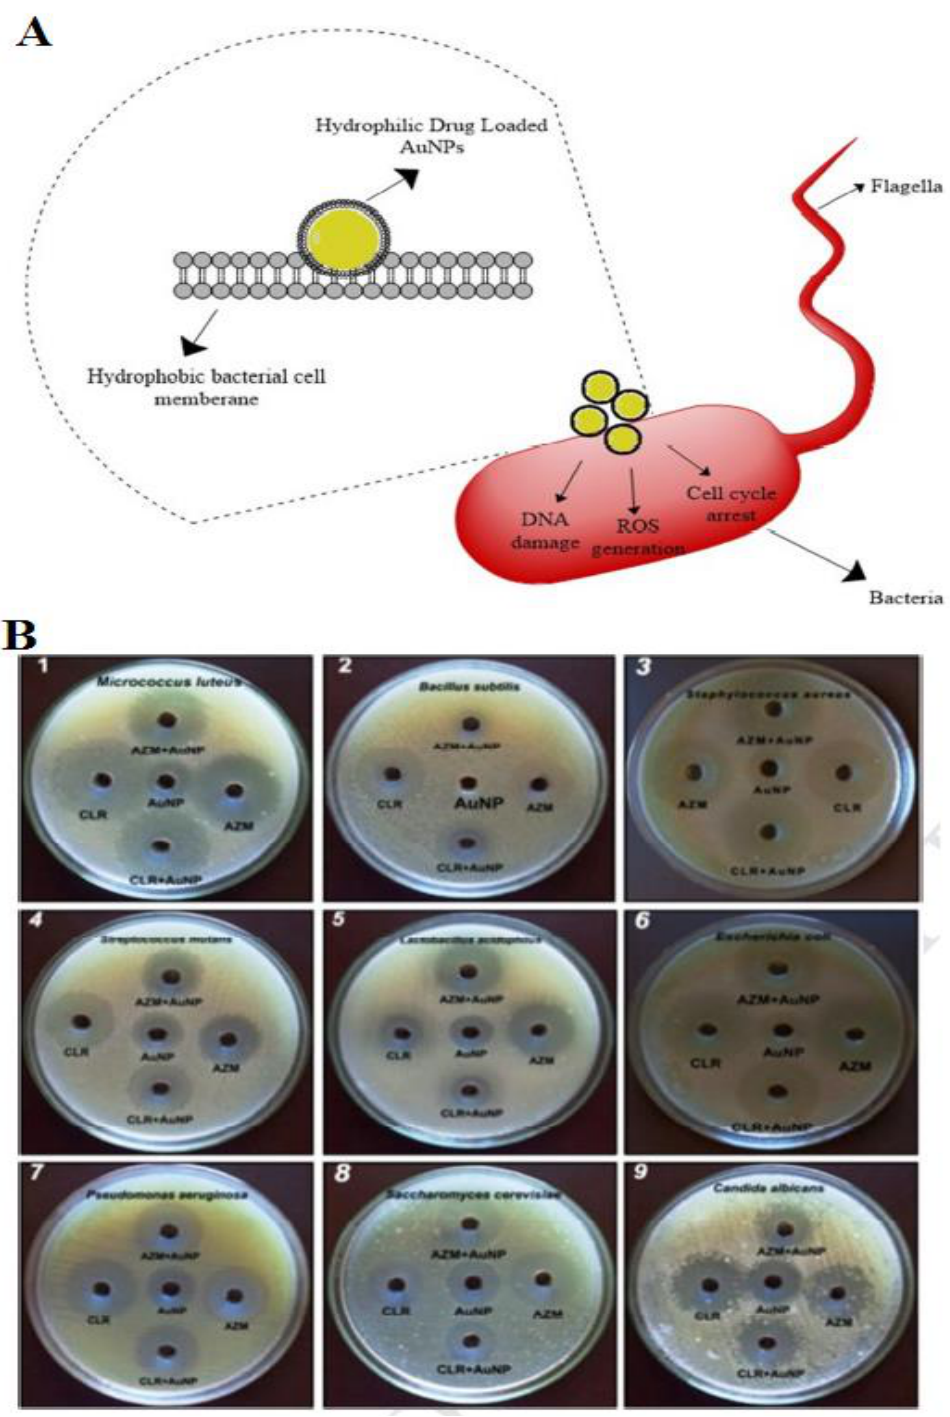
Figure 4. Schematic illustration of the killing of bacterial cells by Au NPs ( A ); schematic of spectrum antimicrobial activity of Au NPs, naked drug, and drug-loaded Au NPs against oral pathogenic pathogens. ( B ) The AuNPs (100 µ g) and drug-AuNPs show a wide-spectrum antimicrobial effect against the pathogens. AuNPs exhibited antimicrobial activity through the creation of a zone of inhibition ranging from about 17 mm against pathogens excluding B. subtilis , which shows less of a response with a 9 mm zone [140] . Reprinted with permission from Elsevier.